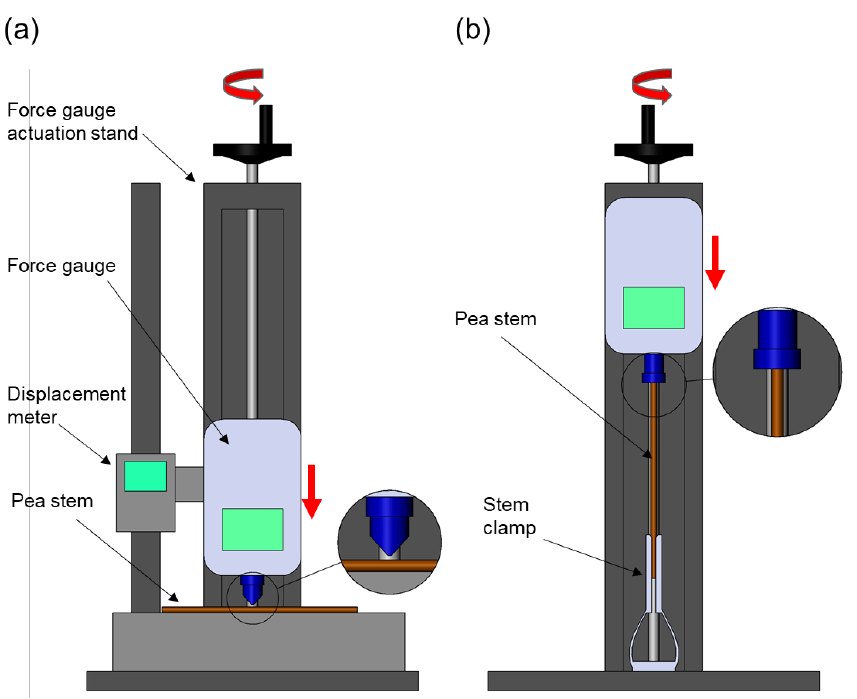
Figure 2. Diagram of measurement conditions for ( a ) compressed stem thickness (CST) and ( b ) stem buckling (SB) in dry field pea stems. In both settings the force gauge was actuated downwards, applying a load over the pea stem. In ( a ) a displacement meter was used to measure the displacement of the stem from its natural stem diameter (SD) to the CST after applying a load of 10 N. For ( b ) the bottom of the stem was restricted with a clamp and the top was fixed under the flat end of the force gauge. SB was measured as the peak force recorded at stem failure.